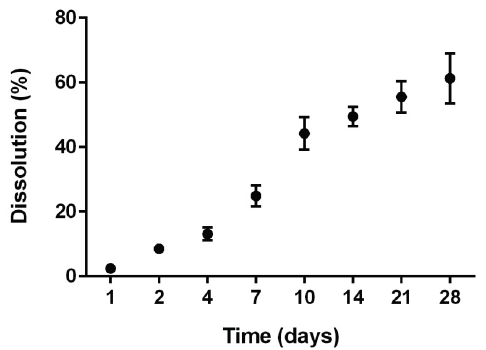
Figure 9. Dissolution behaviour of the NPTH-loaded porous scaffolds as a function of time. Measurements were carried out in PBS at pH 7.4 at 37 °C. Data are averaged on three measurements.